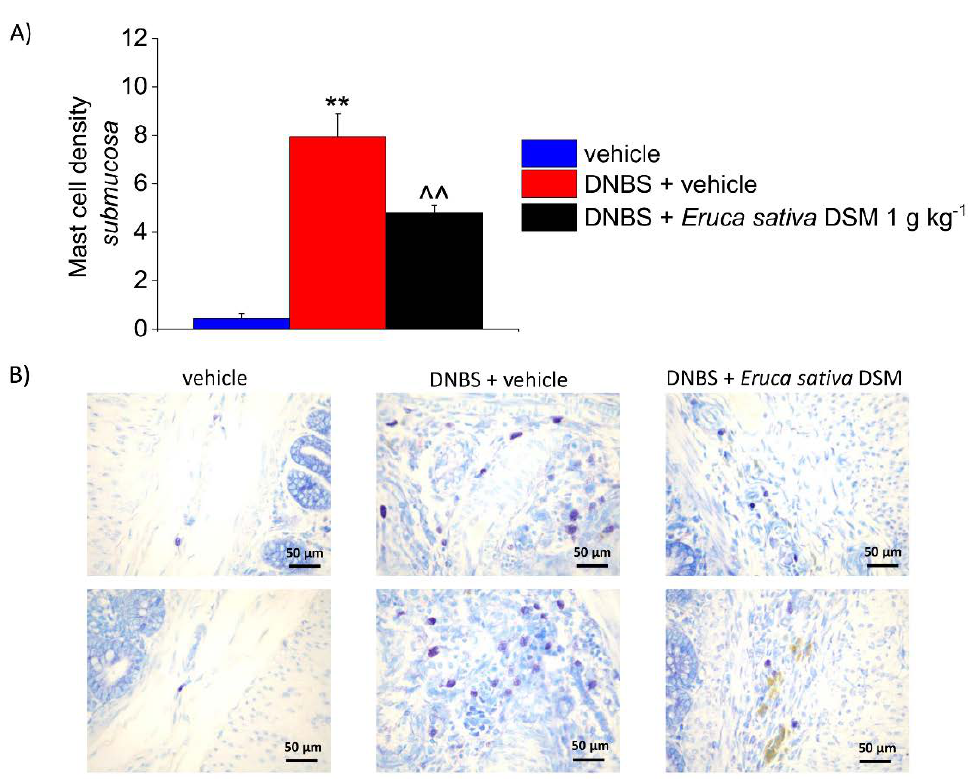
Figure 6. The effect of the repeated treatment with Eruca sativa DSM on submucosal MCs increase, induced by DNBS. Eruca sativa DSM (1 g kg − 1 ) was administered once daily in the DNBS-treated animals, starting from the day of DNBS injection for 14 consecutive days, then tissues were collected. Column graphs display the mean values of MCs density per area of colonic wall (cells/field) ( A ). The panel shows pictures captured from submucosa of MCs stained with GIEMSA ( B ). Each value represents the mean ± SEM of six animals per group. ** p < 0.01 vs. vehicle. ^^ p < 0.01 vs. DNBS. Original magnification: 40×.